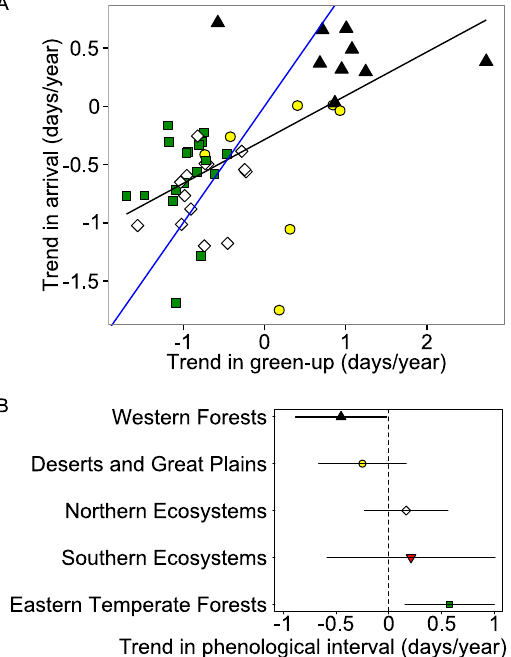
Figure 2. Ecoregional differences in arrival trend vs. green-up trend relationship and in explaining trend in phenological interval. ( A ) Relationship between trend in bird species arrival and trend in green-up. Each symbol represents a species, and symbol colour and shape indicate the primary ecoregion of the species’ breeding range, as defined in Fig. 1 (only the most occupied region shown). Black line indicates linear regression for all species ( p < 0.001), blue line indicates where trend in arrival equals trend in green-up. The trend for all species was statistically significantly ( p = 0.004) different from slope = 1 (blue line), indicating trend in arrival changed less than trend in green-up. ( B ) Ecoregions as linear regression coefficients predicting trend in phenological interval across species. Bars indicate 95% confidence